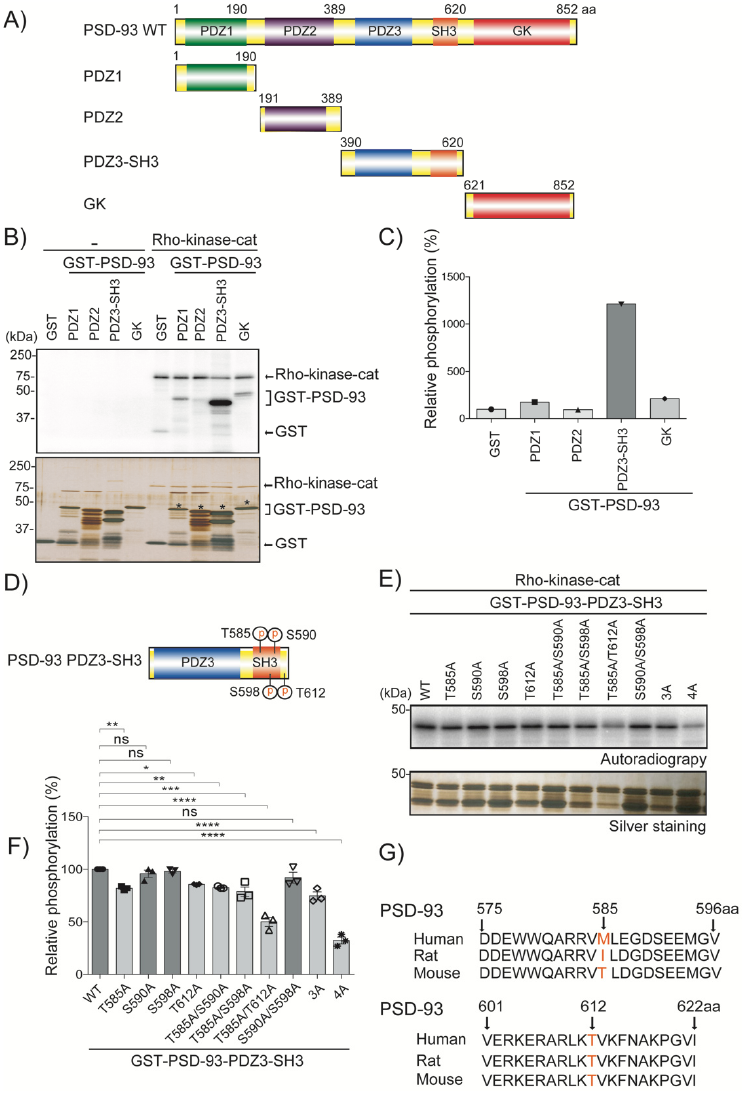
Figure 1. Rho-kinase phosphorylates PSD-93 in vitro. ( A ) PSD-93 domain organization: three PDZ domains (PDZ1 PDZ2 and PDZ3), one SH3 domain and one GK domain. The numbers represent amino acids. ( B ) Constitutively active Rho-kinase phosphorylated PSD-93 at the PDZ3-SH3 do- main. Purified GST and GST-PSD-93 domain proteins were incubated with [ γ 32 P] ATP in the presence or absence of Rho-kinase-cat in vitro. Samples were subjected to SDS-PAGE and silver staining followed by autoradiography. Asterisks denote intake GST-PSD-93 fusion domain pro- teins. The arrows denote recombinant Rho-kinase-cat and GST. Third bracket represents PSD-93 domain proteins. ( C ) The bar diagram shows the relative phosphorylation (%) of PSD-93 domain proteins. ( D ) Schematic presentation of PSD-93 phosphorylation sites. The PSD-93-PDZ3-SH3 do- main contains four putative phosphorylation sites based on Rho-kinase consensus motifs of R/KXXpS/T and R/KXpS/T (R, arginine; K, lysine; X, any amino acid; S, serine and T, threonine). P denotes phosphate group. ( E ) Rho-kinase phosphorylated PSD-93-PDZ3-SH3 domain at four dif- ferent sites. Purified wild-type and phospho-deficient mutants of PSD-93-PDZ3-SH3 were incu- bated with Rho-kinase-cat along with [ γ 32 P] ATP in vitro. Next, the SDS-boiled samples were sub- jected to SDS-PAGE and silver staining followed by autoradiography. The upper panel shows au- toradiography, and the lower panel shows a silver staining image. ( F ) Bar diagram showing the relative phosphorylation (%) of PSD-93 domain proteins. The horizontal lines indicate the mean ± SEM of three independent experiments.*, **, *** and **** represent p < 0.05, p < 0.01, p < 0.001 and p < 0.0001, respectively, for Dunnett’s multiple comparisons test. “ns” denotes “not significant”. ( G ) The amino acid sequence homology of PSD-93 phosphorylation sites (Thr585 and Thr612) in dif- ferent species (humans, rats, and mice) is shown in a schematic graph. The numbers represent the amino acid position.